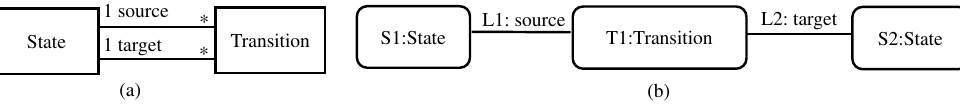
Figure 6. Type graph ( a ) and Typed graph ( b ). The star (*) indicates that zero or more instances of the class “Transition” are associated with one instance of the class “State”.